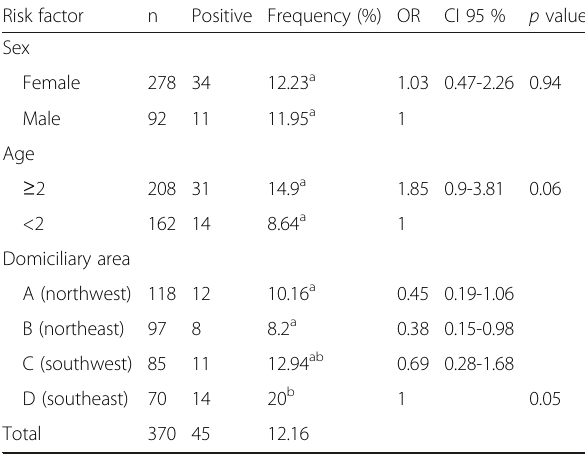
Table 1 Risk factors, odds ratios and confidence intervals associated with positive results for T. cruzi in 370